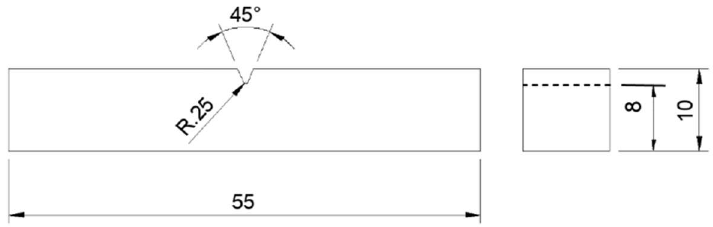
Figure 2. Schematic diagram for the impact testing specimen. (Units are in mm).